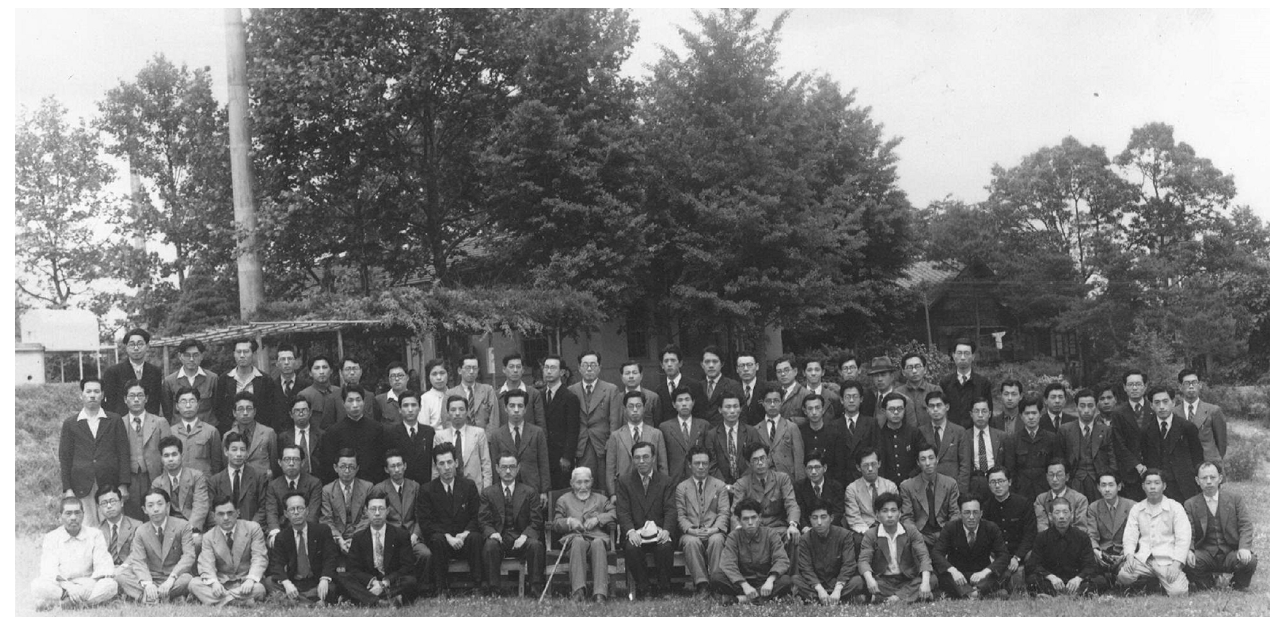
Figure 21. Attendants of the third meeting of the Society of Geoelectromagnetism of Japan which was held at Kakioka in 1948. Tanakadate is on a chair with a stick in the front row (photo supplied by Kakioka Magnetic Observatory).